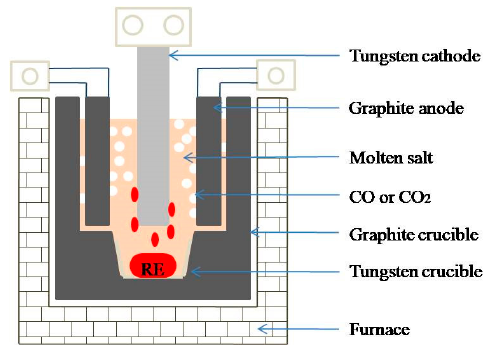
Figure 1. Schematic diagram of molten salt electrolysis.